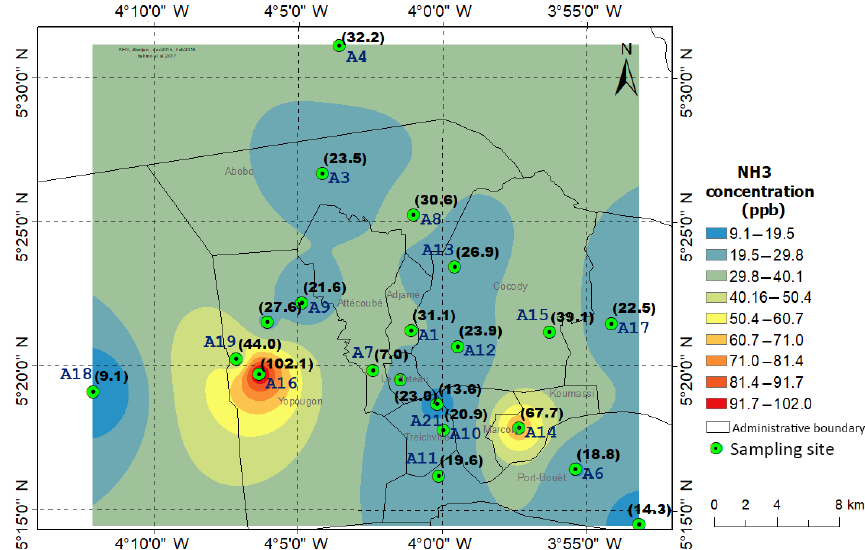
Figure 9. Spatial distribution of NH 3 in the district of Abidjan during the dry season (15 December 2015–16 February 2016). Measured concentrations inppb are in